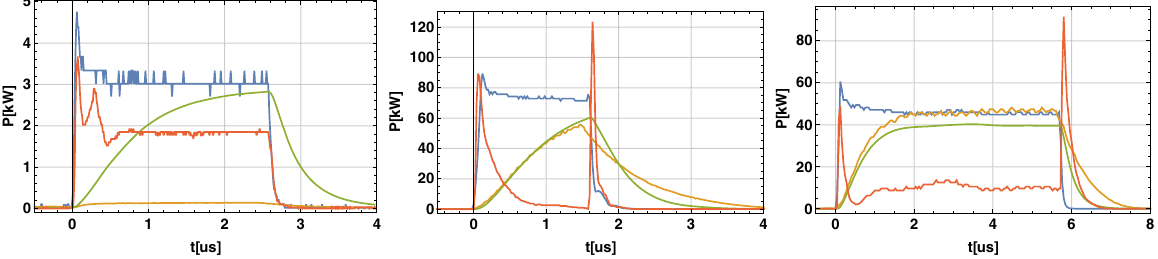
FIG. 9. Waveforms of the measured incident power (blue), reflected power (red), and the stored power reconstructed by the antenna (yellow), P A c , and by the incident power (green), P B c . For DAA2-1-uncoated (left), typical waveforms with multipactor effects are shown. For DAA2-2-DLC (center) and DAA2-3-DLC (right), the waveforms show stable stored power with an accelerating gradient exceeding 10